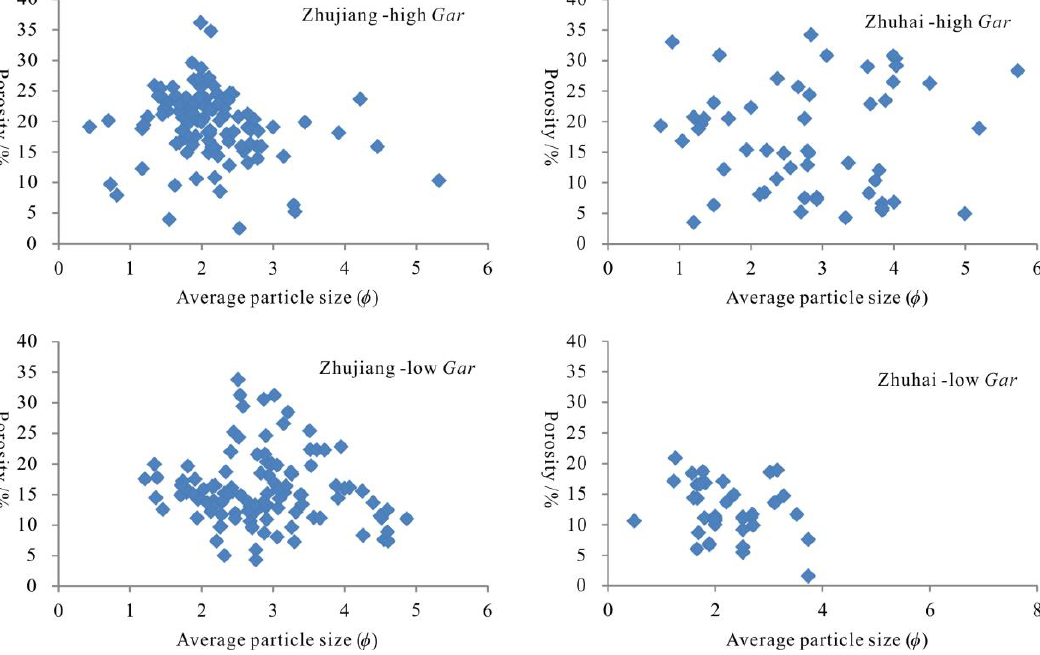
Figure 6. The relation between average grain size and porosity of the Zhujiang and Zhuhai groups in the high and low geothermal gradient ( Gar ) areas. the high and low geothermal gradient ( Gar )